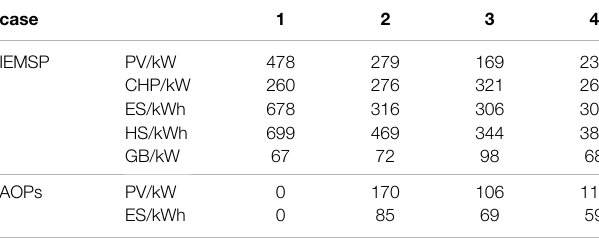
TABLE 1 | Capacity allocation result of four cases.